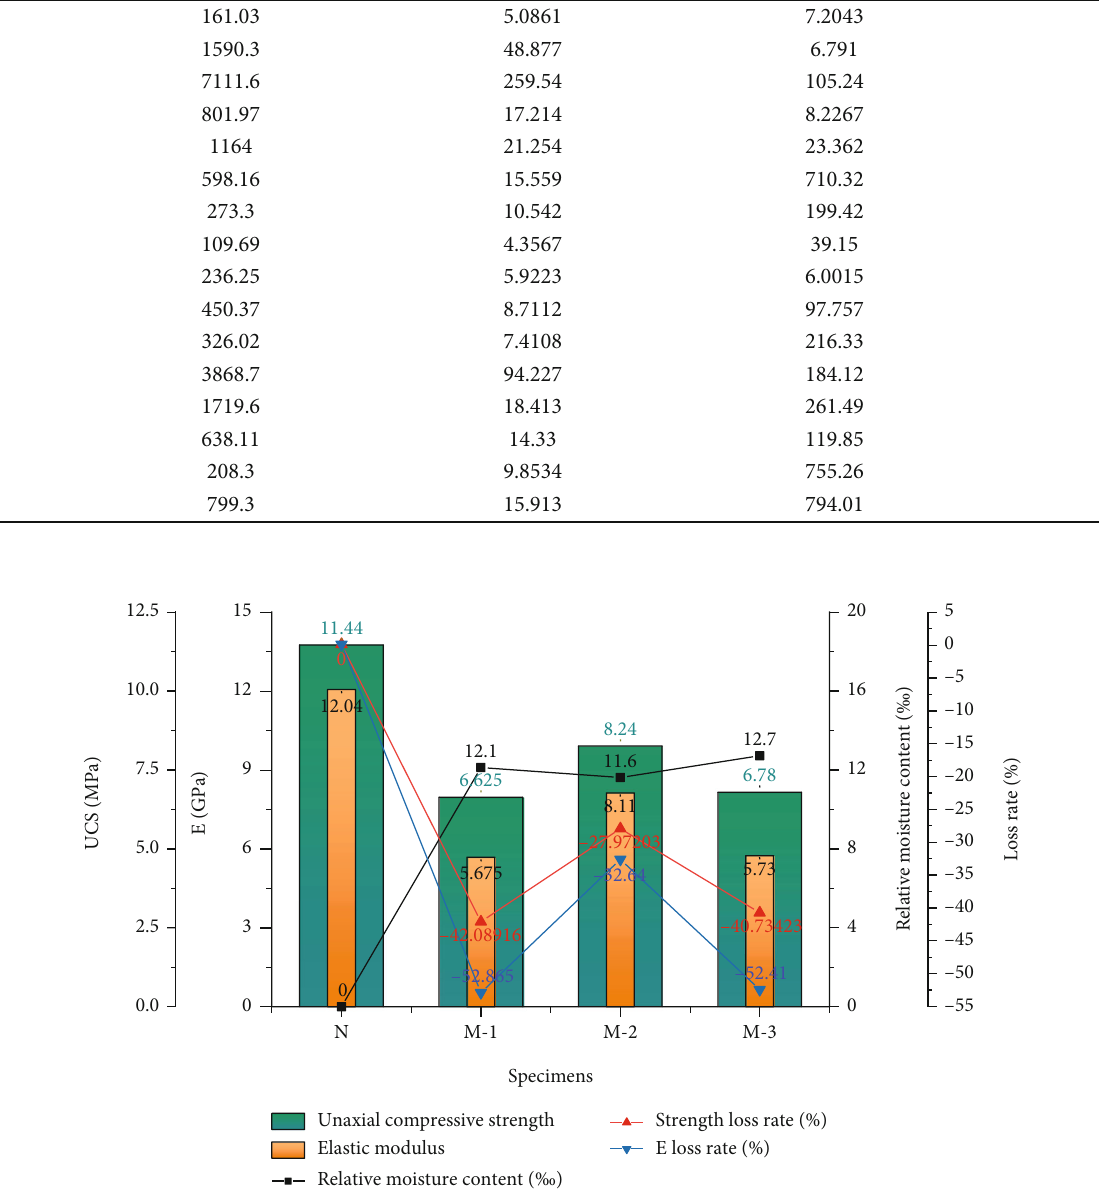
Table 3: Surface hardness and elastic modulus ( E ) test results of the dry and moist states.